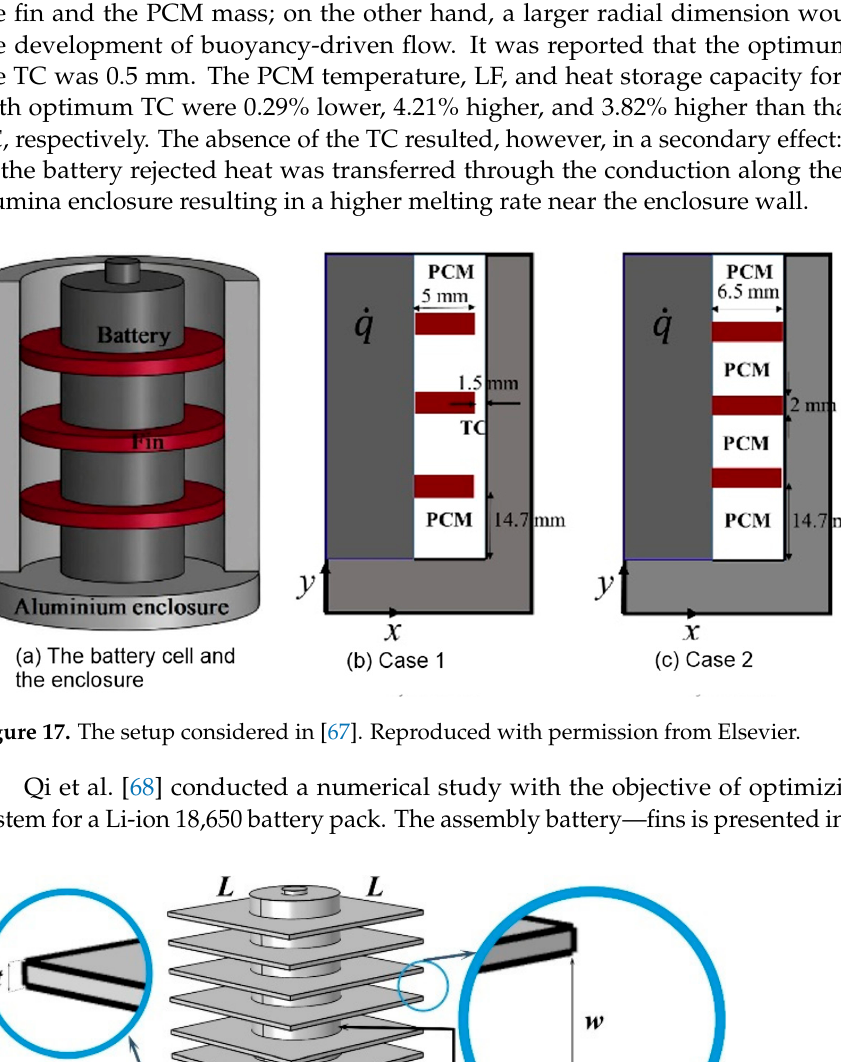
Figure 17. The setup considered in [67]. Reproduced with permission from Elsevier.